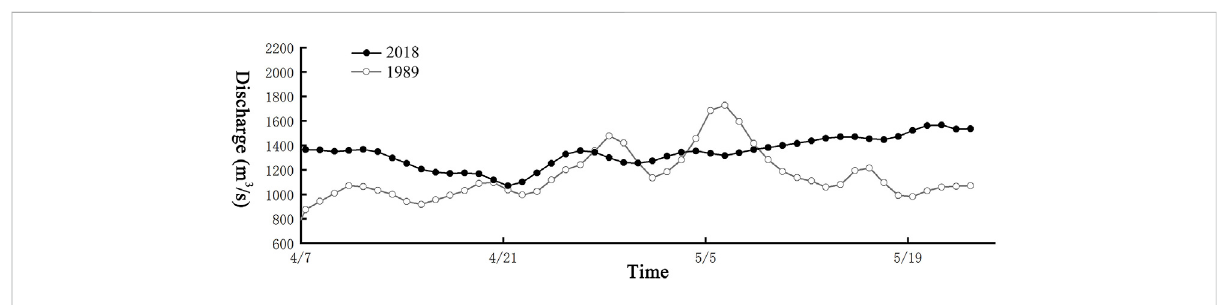
FIGURE 6 Xuzhuang Station represents the annual fl ow process during the pre- and post-dam period at the Xiaolangdi Reservoir on the Yellow River,